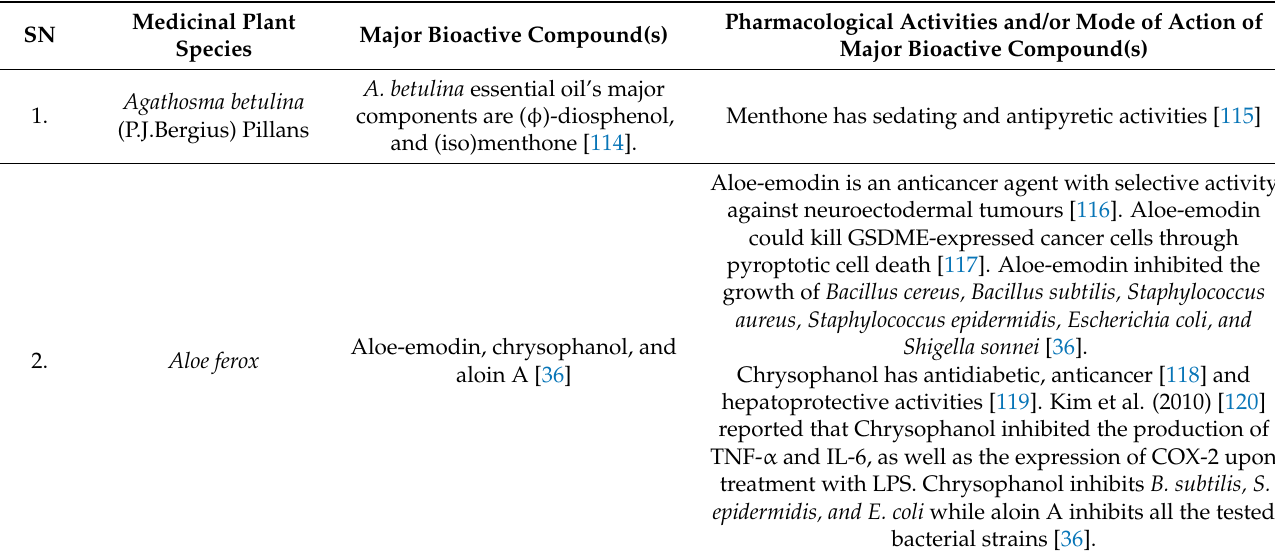
Table 2. Major bioactive compounds of chosen medicinal plants and their pharmacological